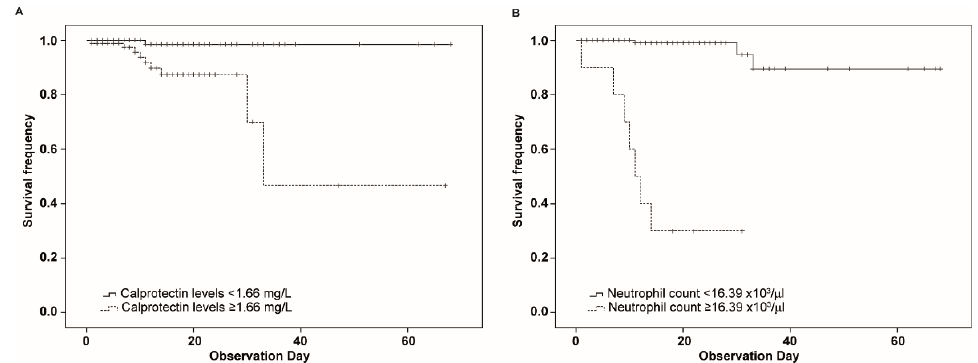
Figure 3. Kaplan – Meier survival curves of patients in relation to calprotectin levels or neutrophil count. ( A ) Patients were divided based on calprotectin levels higher or lower than 1.66 mg/L at the first measurement. ( B ) Patients were divided based on neutrophil count higher or lower than 16.39 × 10 3 /µL at the first measurement. Each vertical drop of the curve represents a single event. Plus signs indicate censored cases.